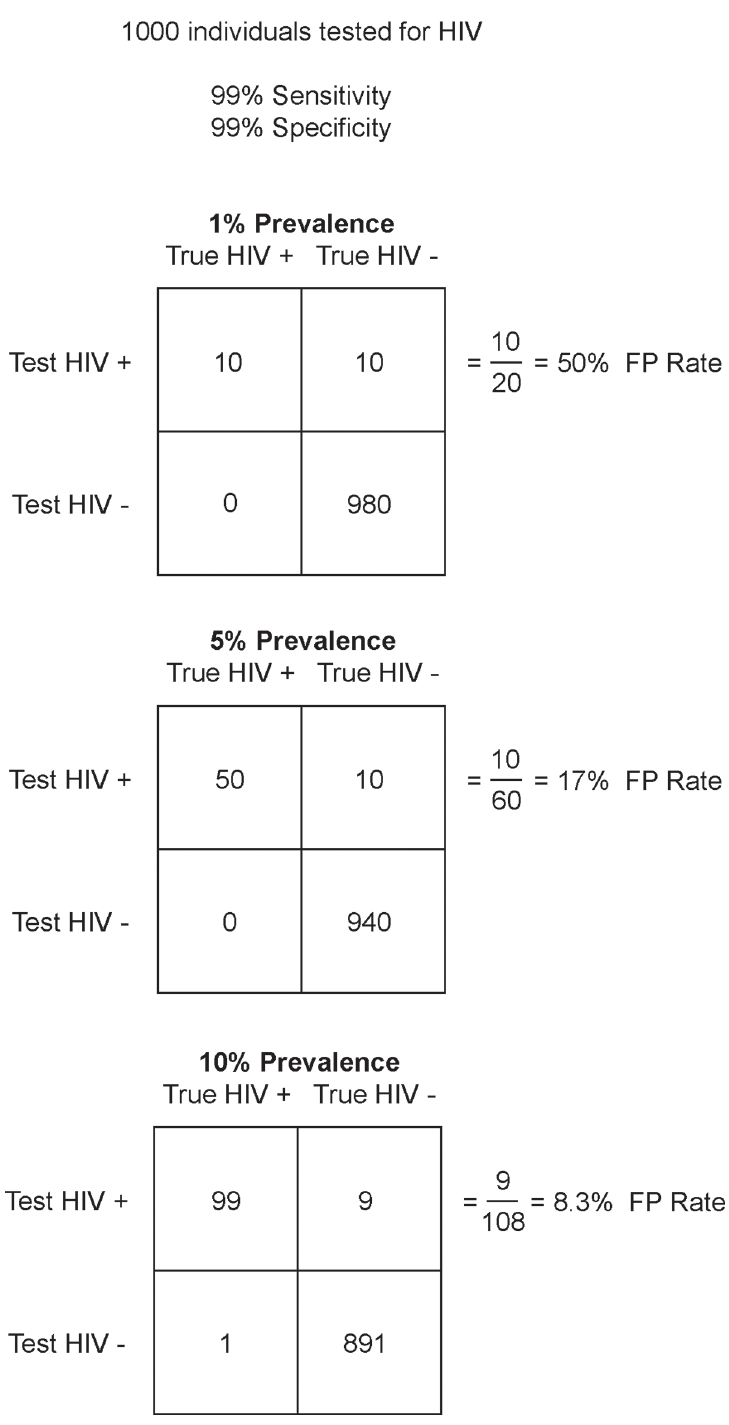
Fig 1. Demonstration of the inverse relationship between HIV prevalenceand proportion of individuals who will incorrectly test positive for HIV, using a hypothetical sample size of 1000 individuals and a rapid test with 99% sensitivity and